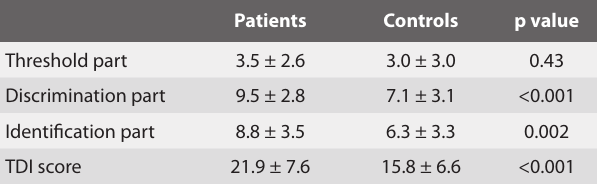
Table 1. Comparison of olfactory scores between patients and controls.